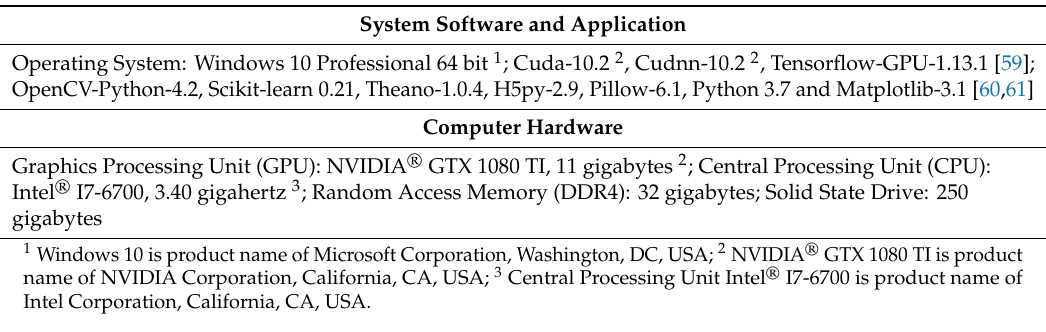
Table 1. The implementation environments used to develop a computer-aided diagnosis system.